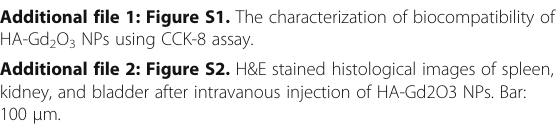
Additional file 1: Figure S1. The characterization of biocompatibility of HA-Gd 2 O 3 NPs using CCK-8 assay. Additional file 2: Figure S2. H&E stained histological images of spleen, kidney, and bladder after intravanous injection of HA-Gd2O3 NPs. Bar: 100 μ